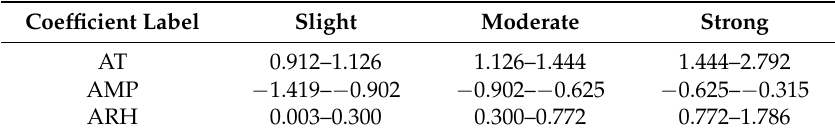
Table 5. Categories of Estimated